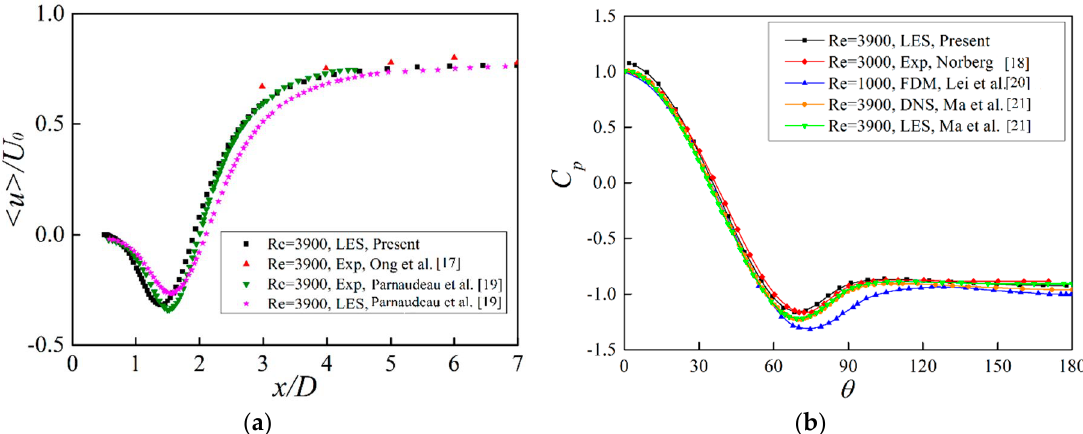
Figure 2. Verification of the numerical approach for flow orthogonally crossing a circular cylinder. ( a ) Streamwise velocity normalized by the free-stream velocity on the centerline in the wake; ( b ) pressure coefficient on the cylinder surface.